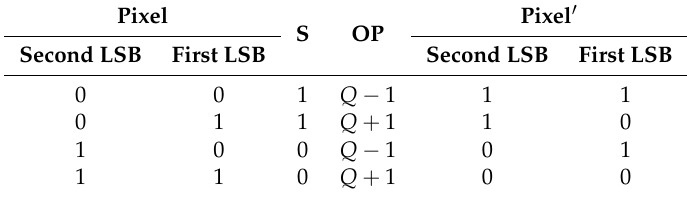
Table 1. Rule of optimal pixel adjustment process (OPAP) for second Least Significant Bit (LSB).